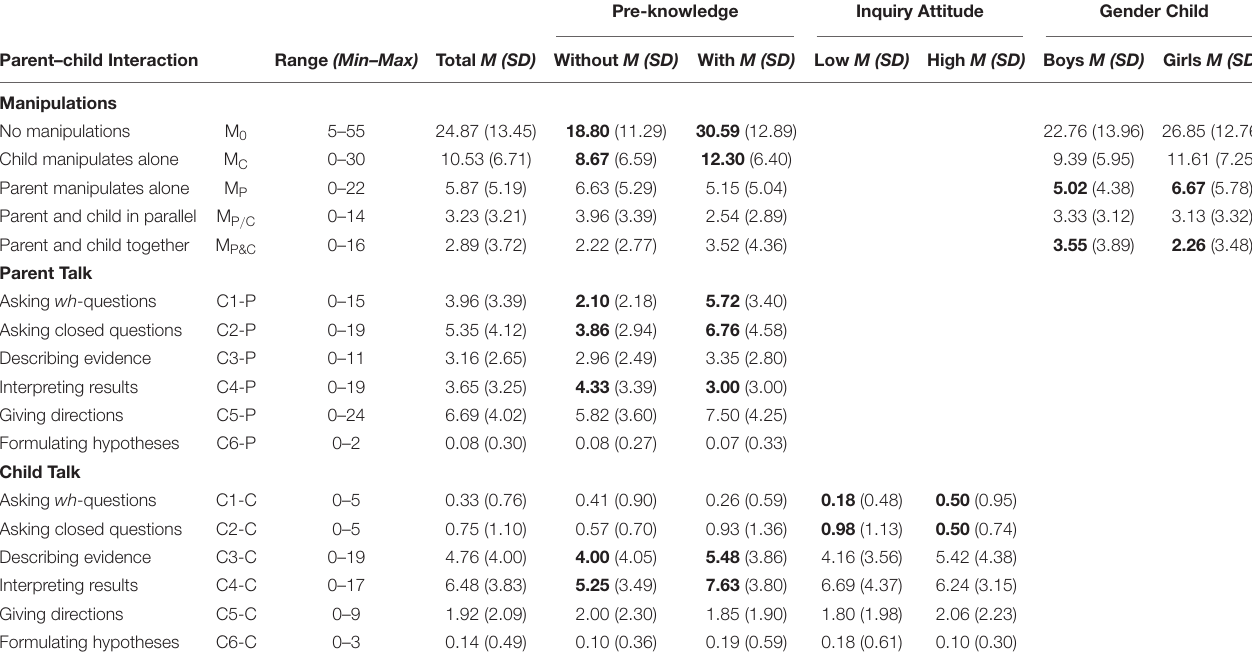
TABLE 2 | Outcome variables, describing parent–child interaction during an inquiry activity in the museum.